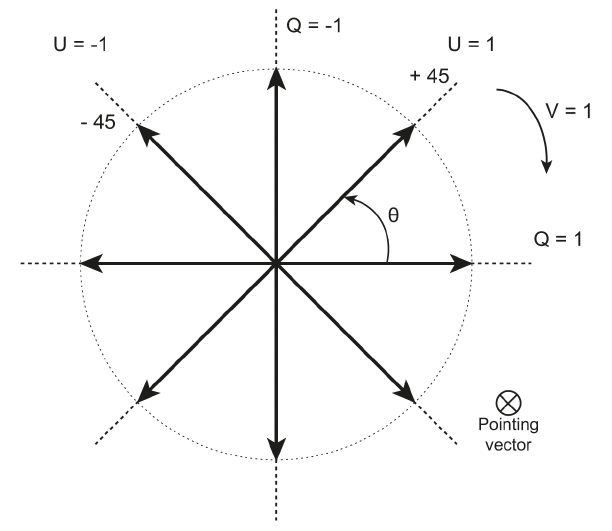
Figure 1. Stokes vector frame definition used in the paper. Pointing vector is perpendicular and into the paper (following the light).